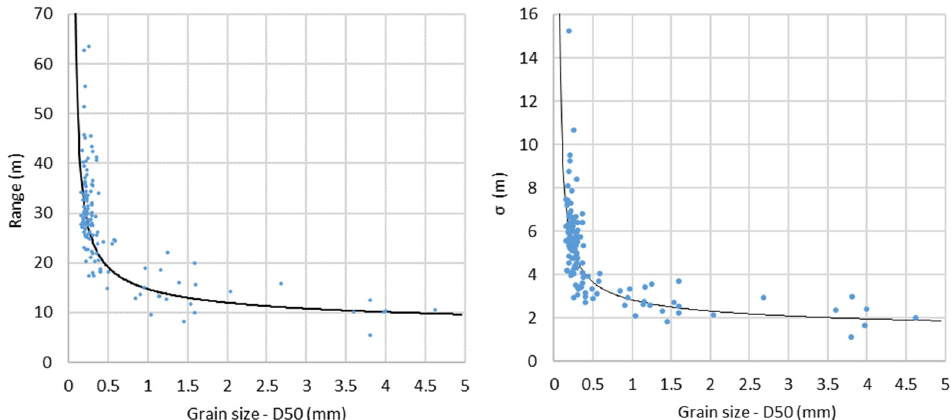
Figure 9. Shoreline variability as a function of sediment grain size. On the left, the relationship is defined for 100 m buffers by the equation: range = 1/(0.0675 + 0.0234*ln(D 50 )). On the right, for 200 m buffers, σ = 1/(0.3522 + 0.1143*ln(D 50 )).